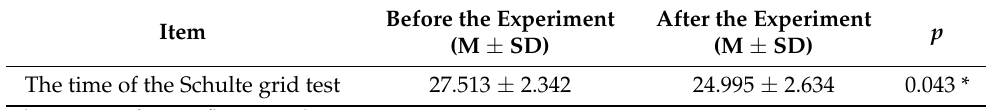
Table 4. The Schulte Grid Test results before and after the experiment in the experimental